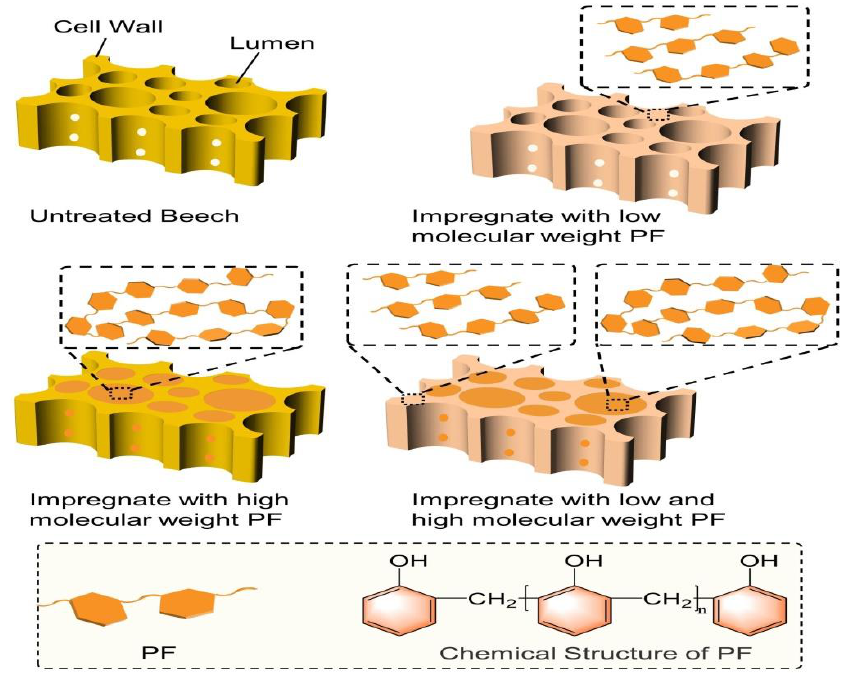
Figure 7. Mechanism underlying the modification of PF resin.